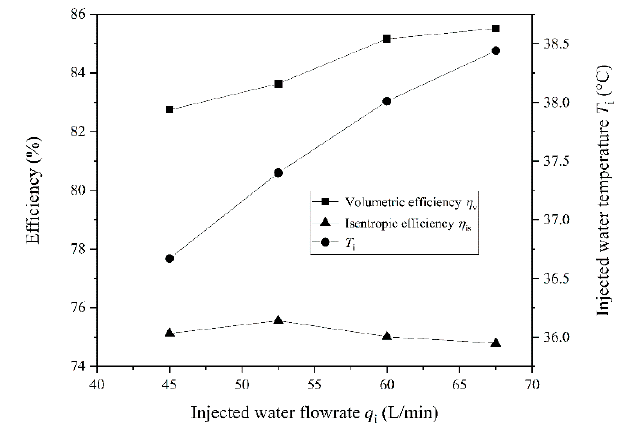
Figure 13. Compressor efficiencies under different injected water flowrates.